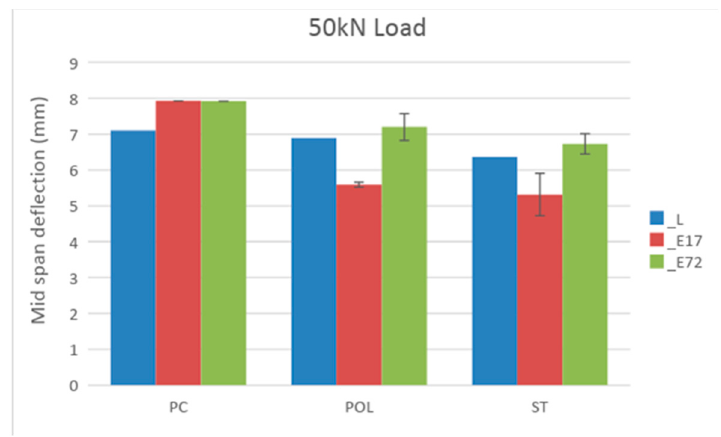
Figure 3. Mid-span deflection values under a service load of 50 kN at the end of the test (17 months for _E17 and 72 months for _E72 beams).